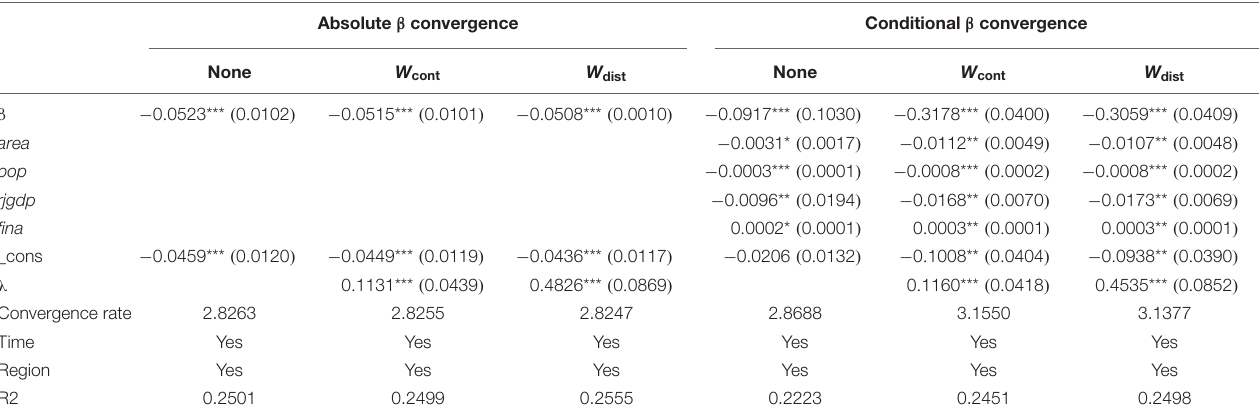
TABLE 2 | Spatial convergence estimation of W-E-F-E